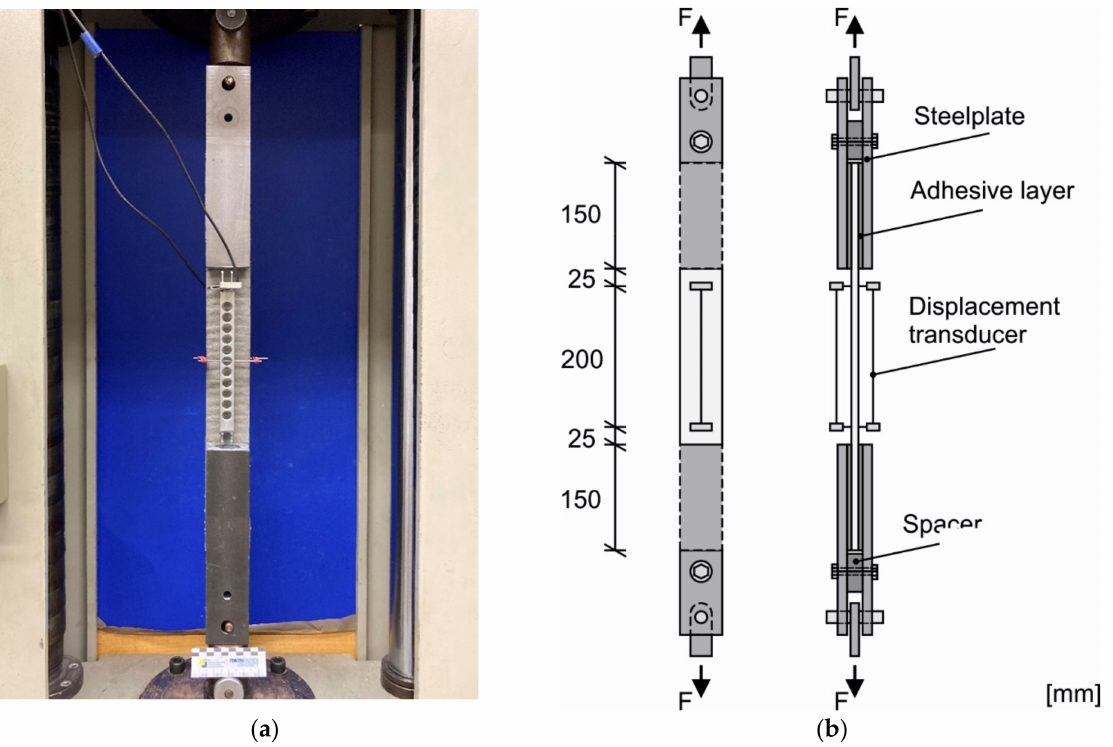
Figure 8. ( a ) Gripping system and specimen in testing machine using adhesive bonding method; ( b ) Scheme of GRIPPS with adhesive system, specimen and measuring manner for determining displacement during the uniaxial tension test, based on